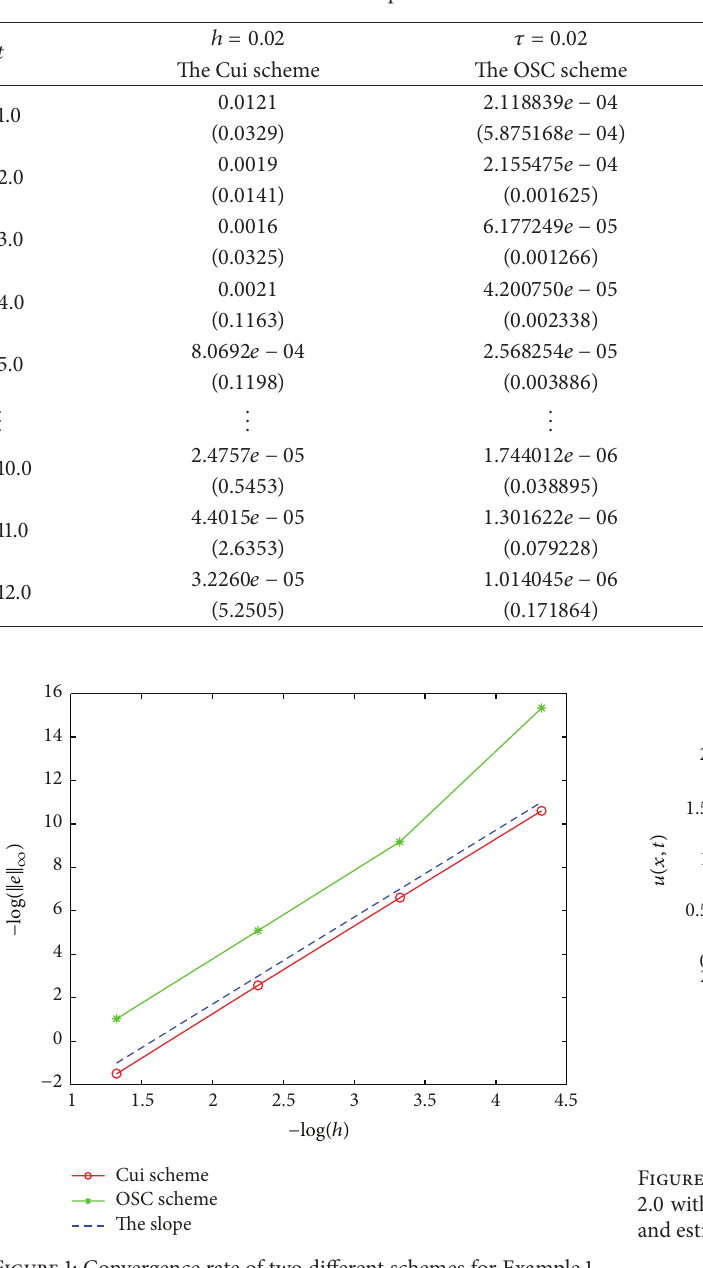
Table 3: Errors comparison of the Cui scheme and the OSC scheme for Neumann problem.